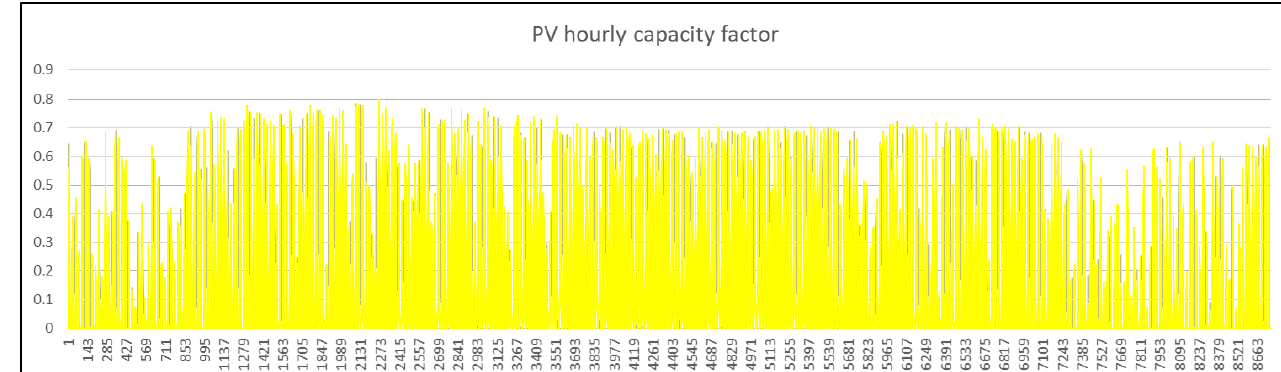
Figure 4. PV hourly Capacity Factor in Procida.